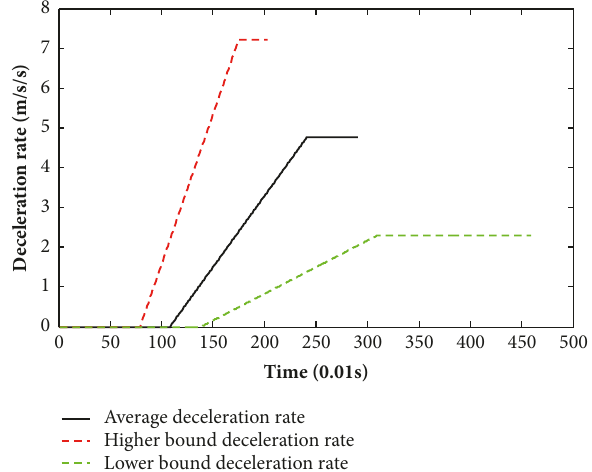
Figure 10: The distribution of deceleration rate (with a 95% confidence